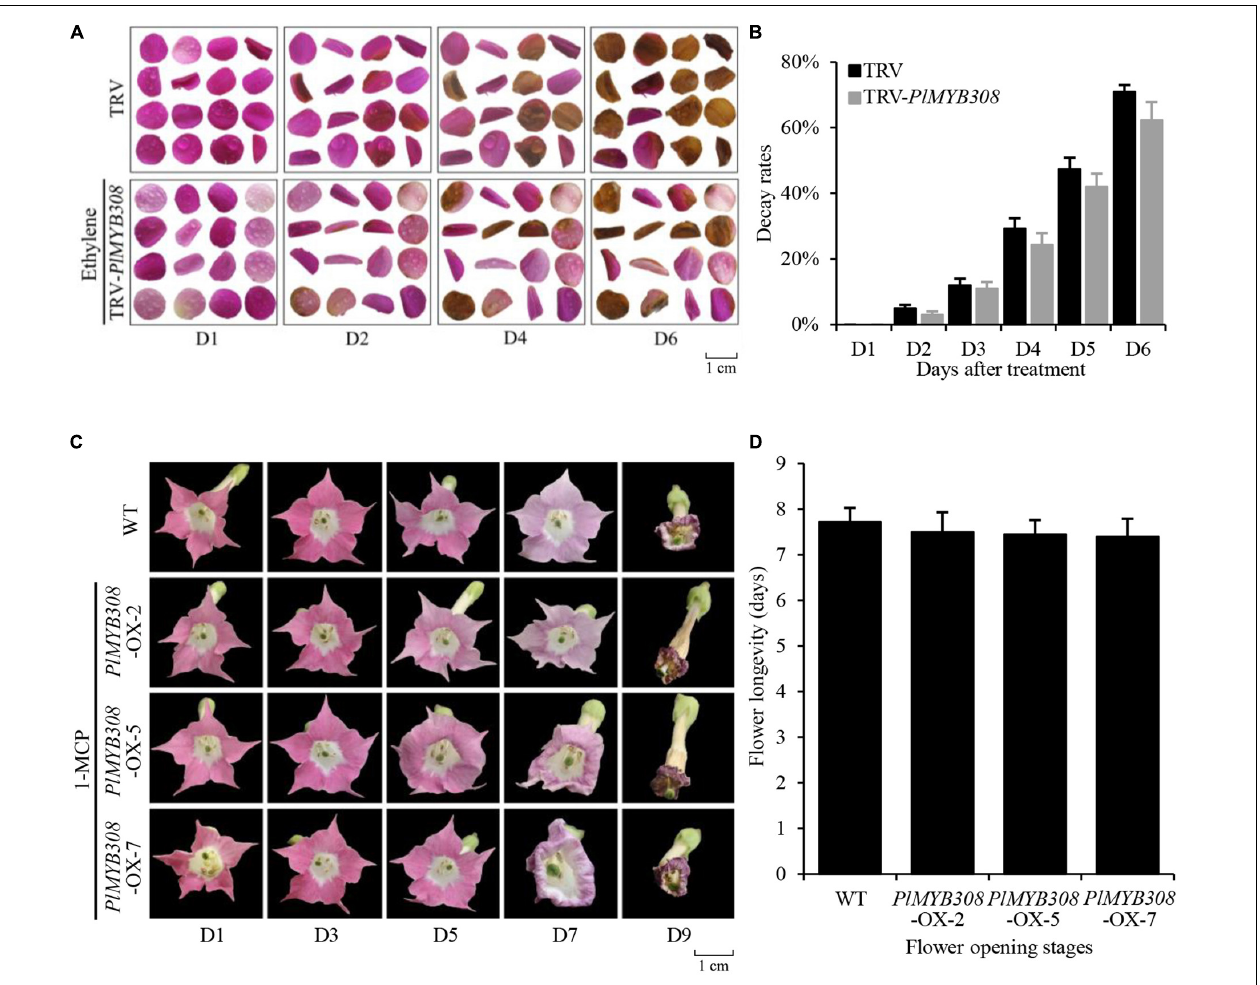
FIGURE 6 | PlMYB308 mediates ethylene biosynthesis during herbaceous peony flower senescence. (A) Treated PlMYB308-silenced petal disks with ethylene and photographed the phenotypes of the TRV empty vector and TRV- PlMYB308 petal disks at D1, D2, D4, D6. (B) The decay rates of the petal disks were recorded from D1 to D6. Means ± SD for 200 petal disks (100 from TRV empty vector and 100 from TRV- PlMYB308 -infected petal disks). (C) Treated PlMYB308 -overexpressing transgenic flowers with 1-MCP and photographed the phenotypes of the WT flowers and PlMYB308 -overexpressing transgenic flowers at D1, D3, D5, D7 and D9. (D) Longevities of the flowers were recorded. Means ± SD for 40 flowers (10 flowers from each PlMYB308 -overexpressed lines and 10 flowers from WT